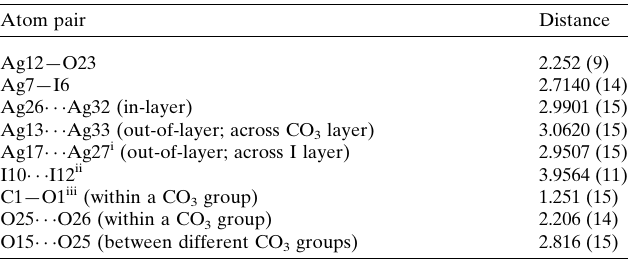
Table 1 Shortest interatomic distances (A˚ ) in the crystal structure of